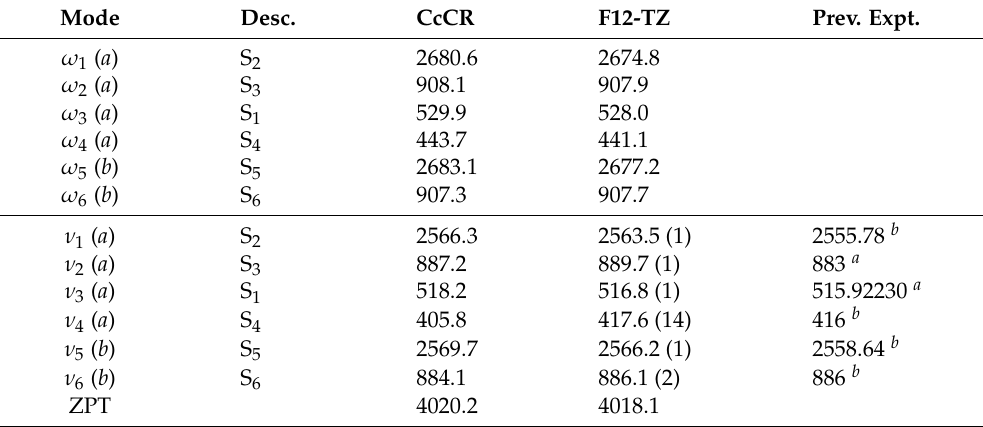
Table 8. Vibrational frequencies (cm − 1 ), and IR intensities (km/mol) given in parentheses for HSSH compared to the previous gas-phase experiment. Mode Desc. CcCR F12-TZ Prev.